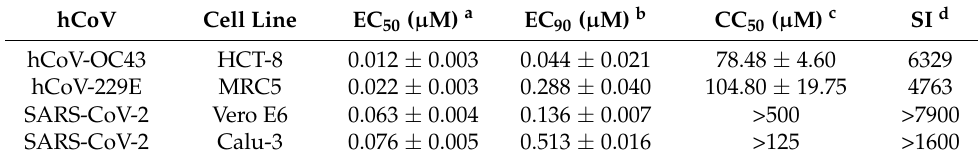
Table 1. Antiviral activity of MEDS433 against different human